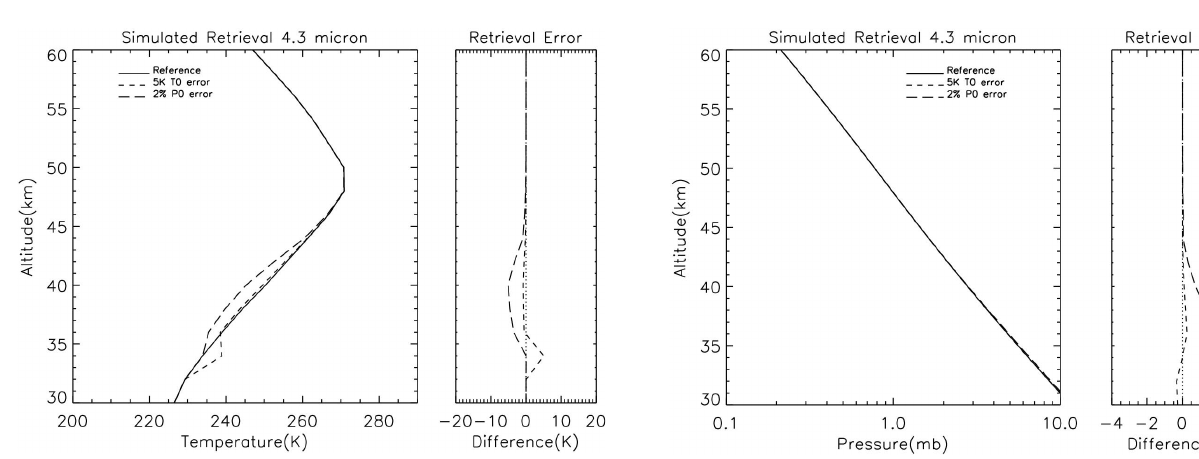
Fig. 8. Same as Fig. 7 but for